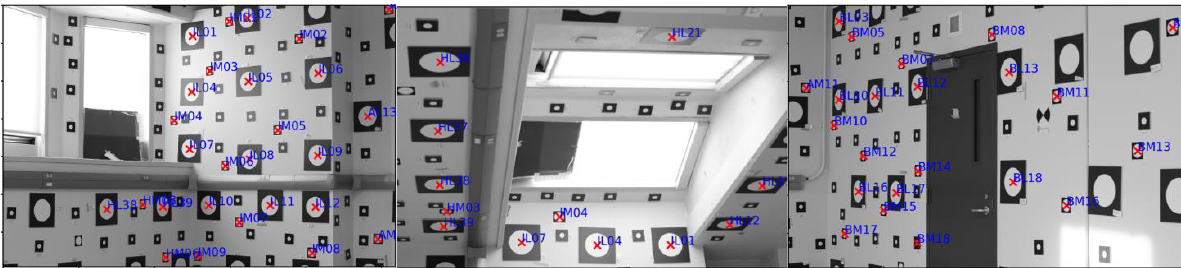
Figure 8. Selection of images from Canon Rebel T3i with detected and labelled targets